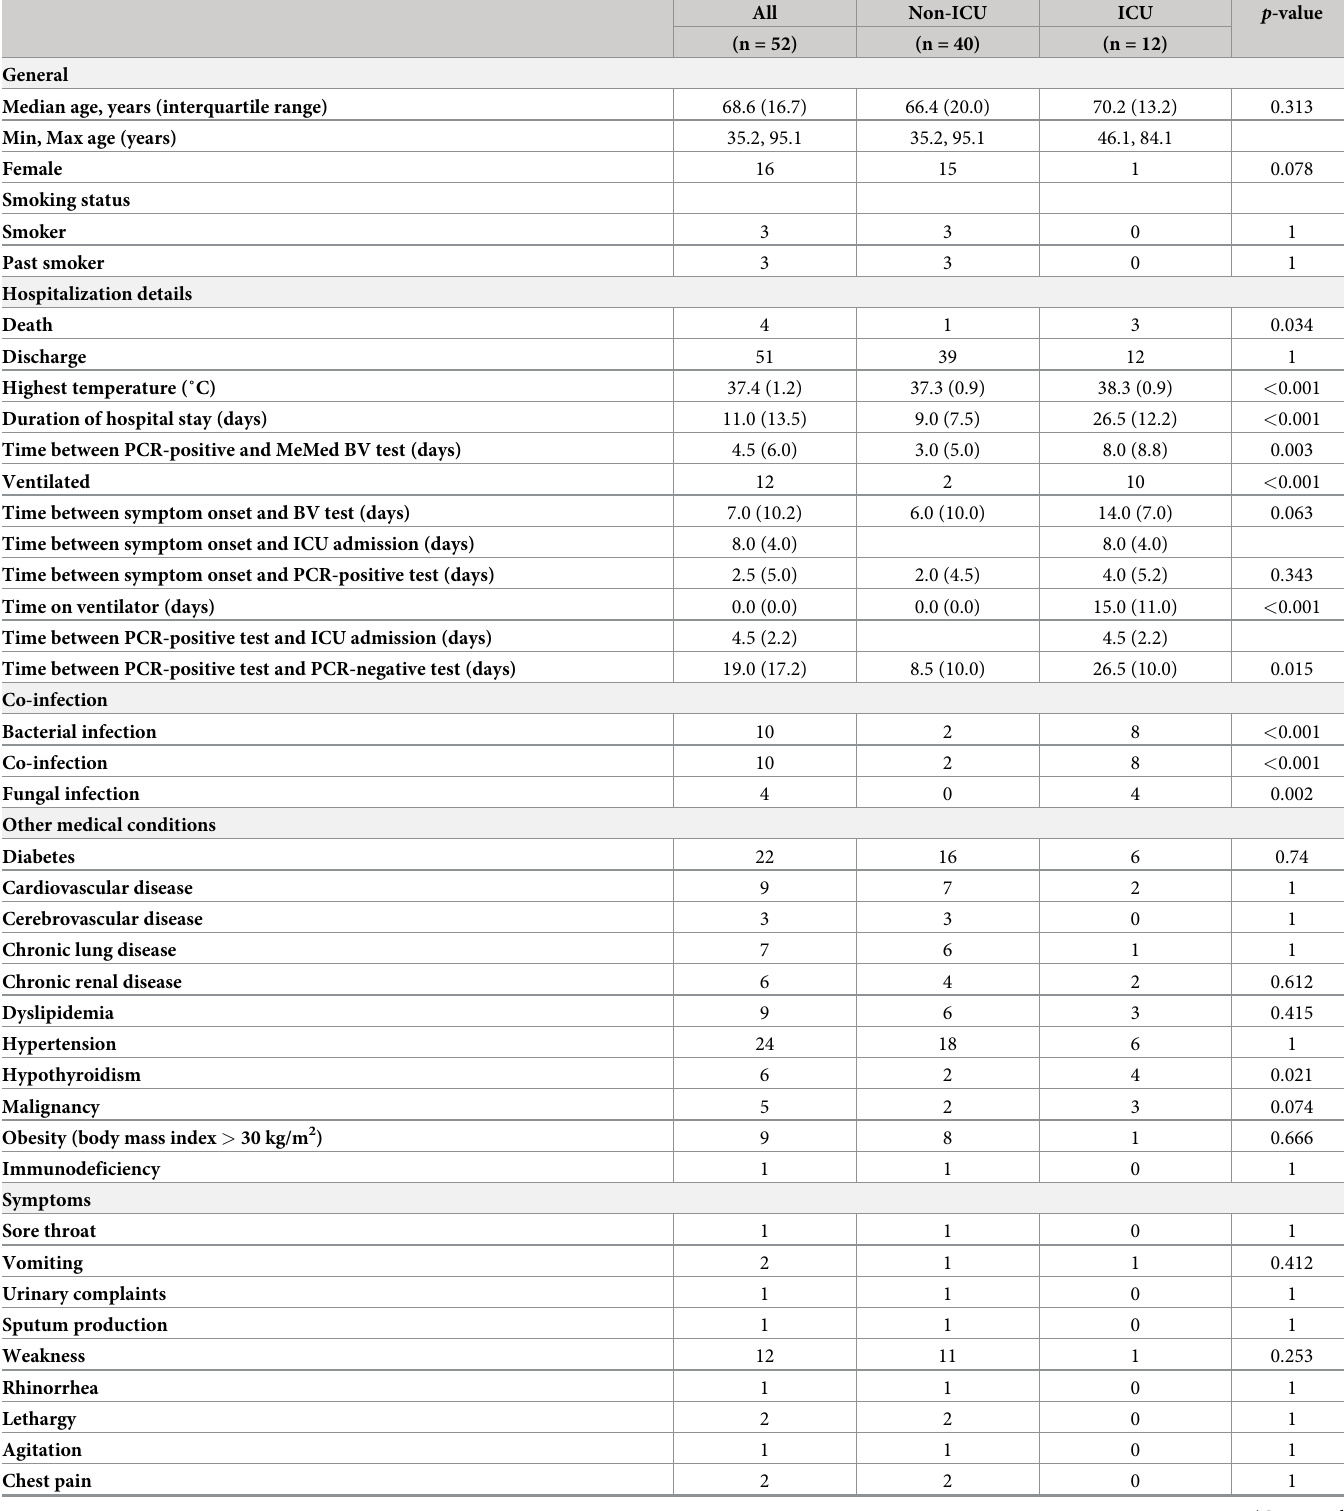
Table 1. Characteristics of COVID-19